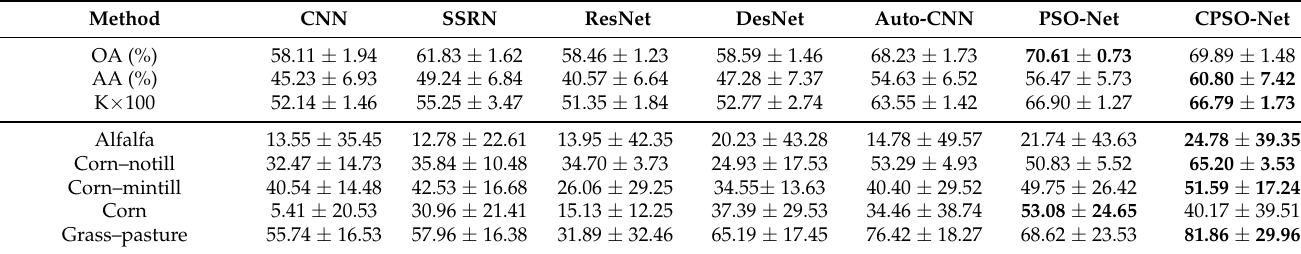
Table 10. Classification accuracy with bolding the best accuracy based on the unbiased Indian Pines dataset, run five